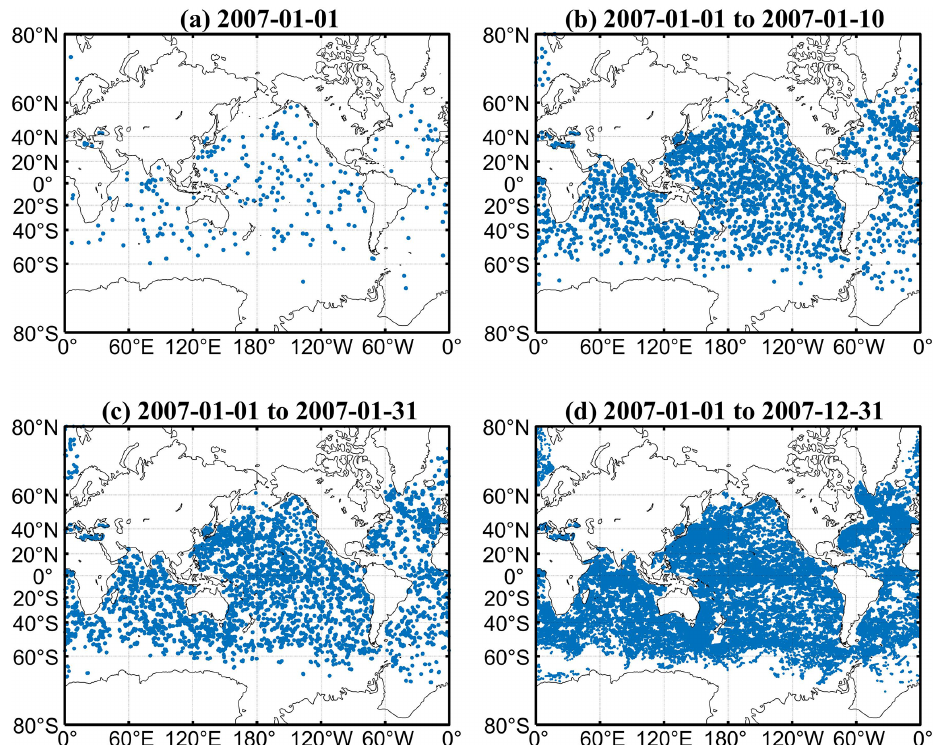
Figure 11. Argo locations on (a) 1 January 2007, (b) 1 to 10 January 2007, (c) 1 to 31 January 2007, and (d) 1 January to 31 December 2007.